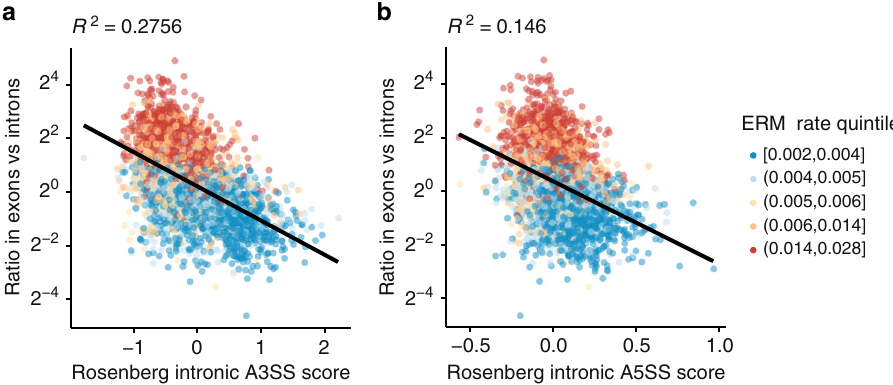
Fig. 5 Mutational bias and selection on the protein code shape the evolution of ISEs. Scores of intronic splicing enhancer (ISE) activity 25 ( x axes) are negatively correlated with motif-level mutability (ERM rate quintiles) and exonic versus intronic enrichment in the human genome ( y axis). This is the opposite of the positive correlation seen in Fig. 2c, d and Supplementary Fig. 2a, b for ESEs. Rosenberg a intronic A3SS and b intronic A5SS scores of ISE activity are based on the effect (log 2 odds ratio) of intronic hexamers on alternative 3 ′ /5 ′ splice site usage as measured by high-throughput minigene experiments. a , b Squared Pearson ’ s correlations ( n = 4096 hexamers). Source data are provided as a Source Data fi